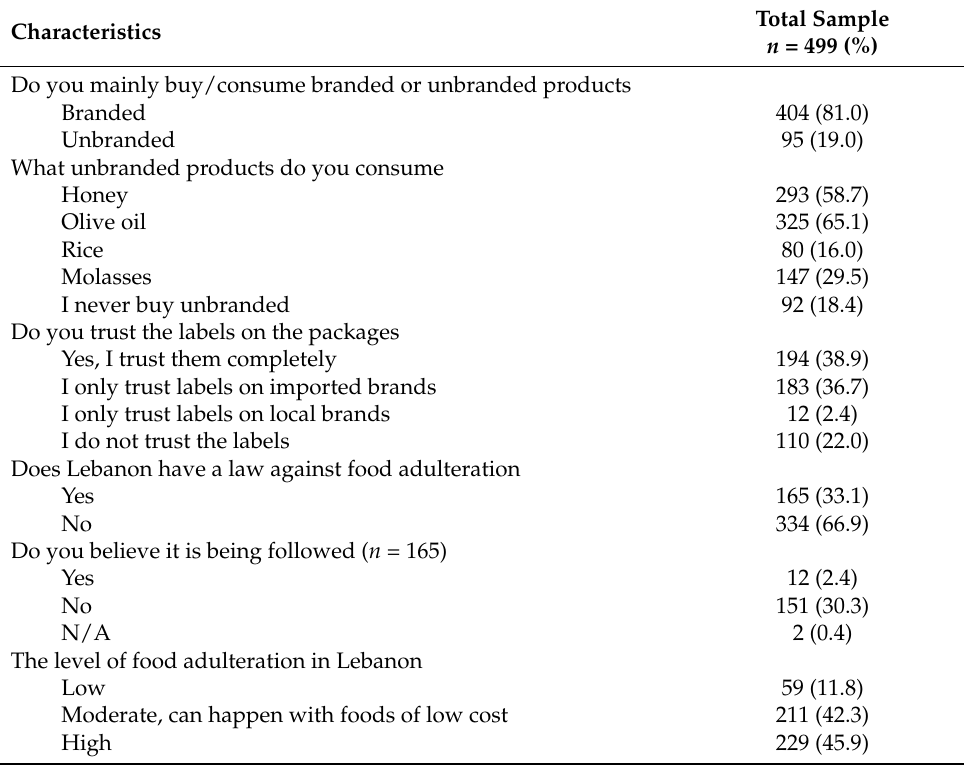
Table 4. Attitudes toward food product labeling and packaging of study